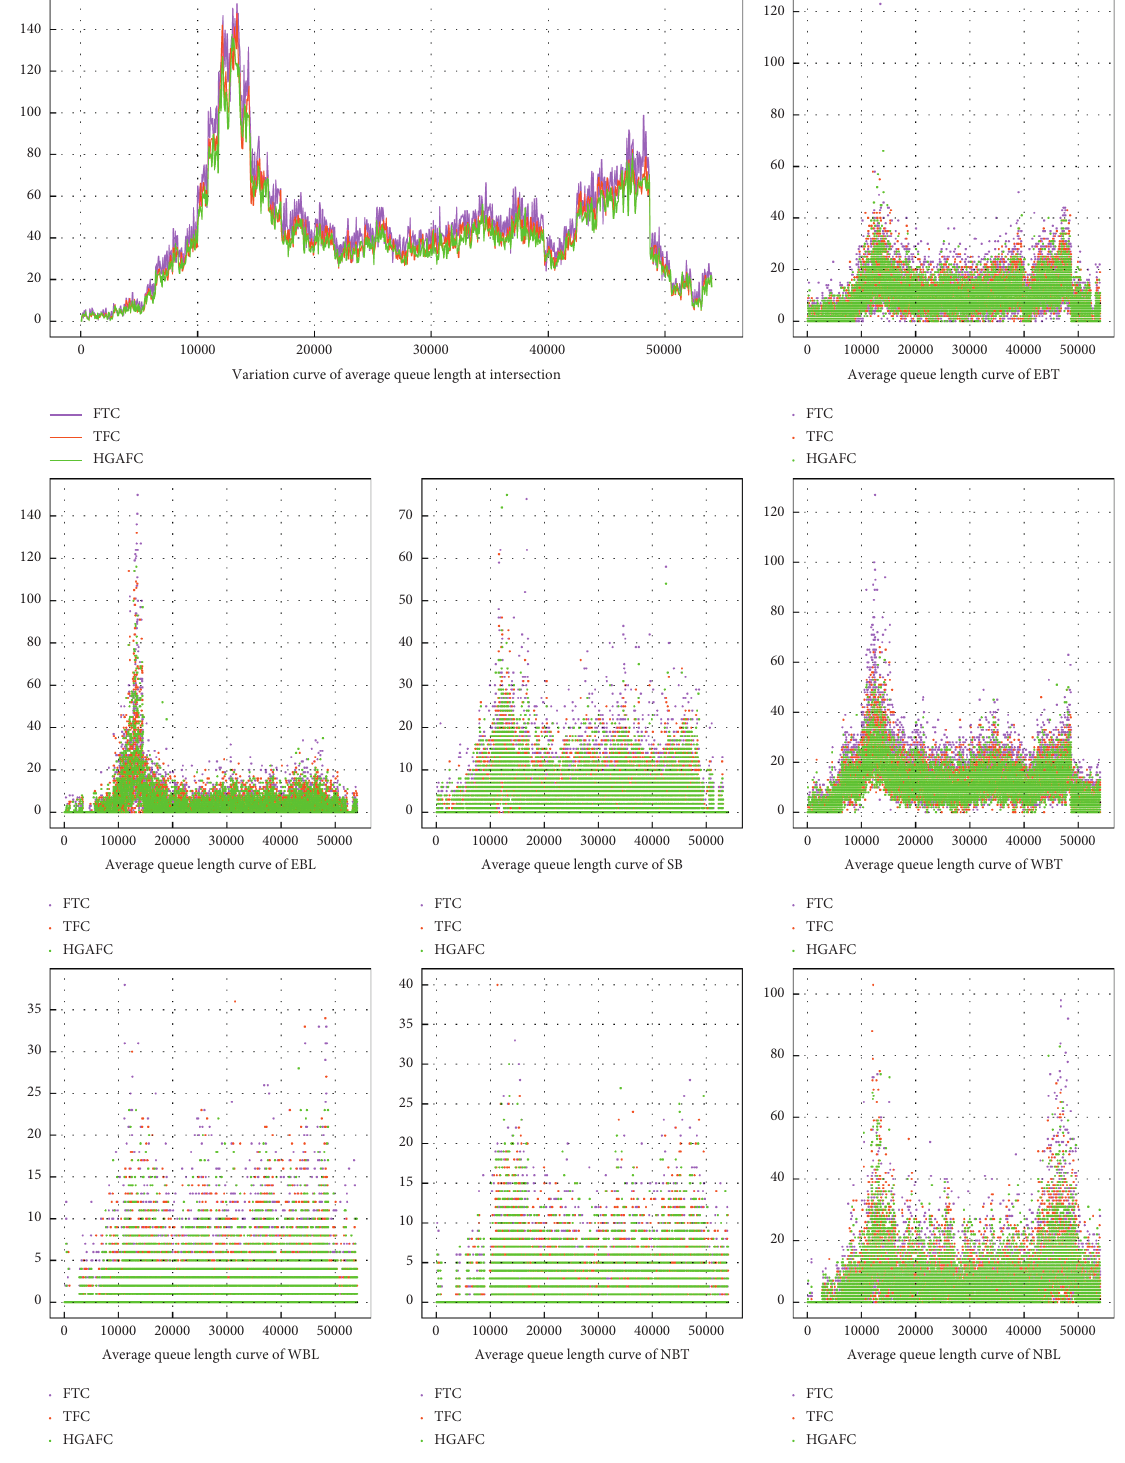
Figure 7: Average queue length curve of different